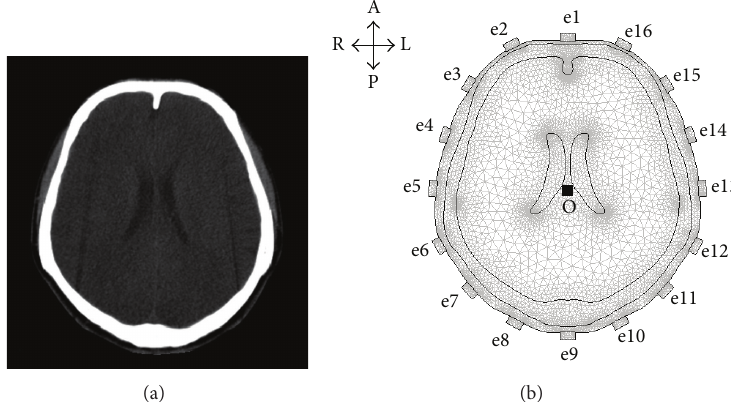
Figure 4: CT image and 2D finite element model of human head used for simulation experiments. (a) A head CT image of a healthy volunteer was used to construct a finite element model. (b) A finite element model (FEM) with an ideally symmetrical structure was constructed according to the right boundary of each layer of head tissues in the head CT image. The 2D head model consisted of 17659 triangular elements,